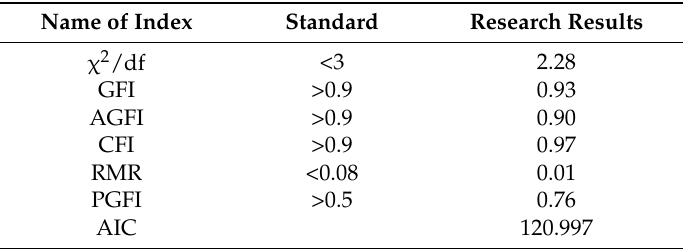
Table 3. Model’s goodness-of-fit